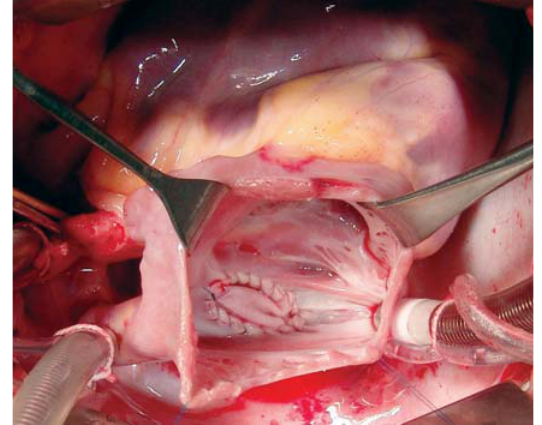
Fig. 5 – Átrio direito aberto com a comunicação interatrial